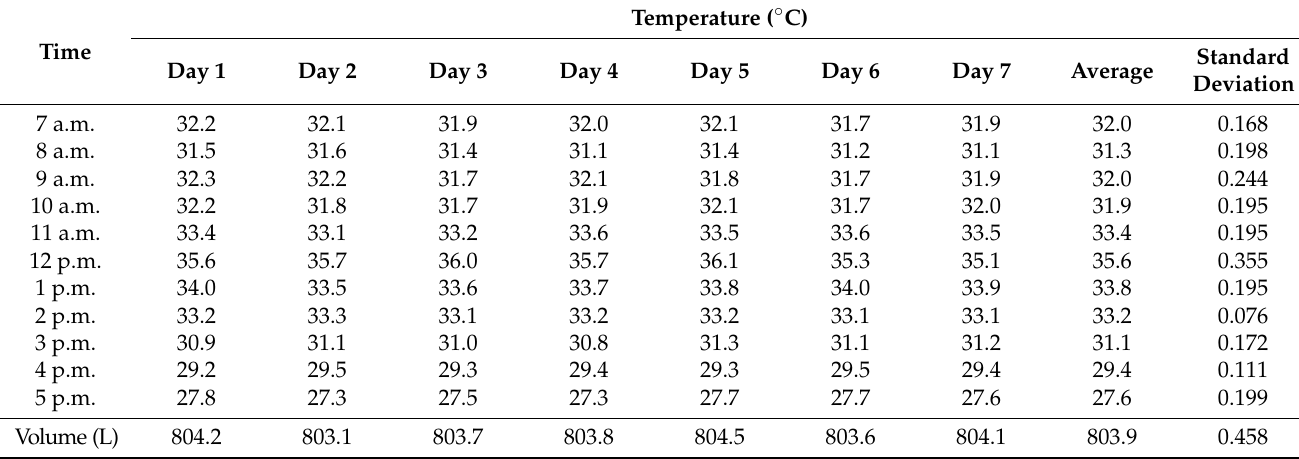
Table 4. Temperature in the greenhouse using the misting system with mass water flow of “80 L/h”.